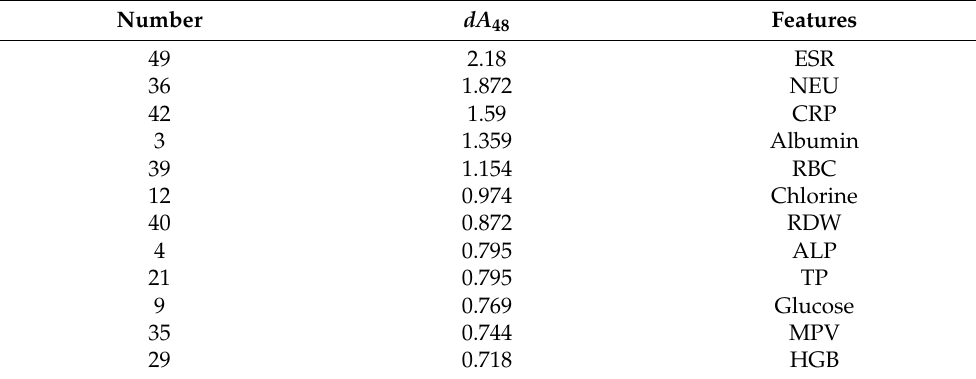
Table 9. The 12 features found to be most important in detecting severely (ICU) and mildly (non- ICU) infected COVID-19